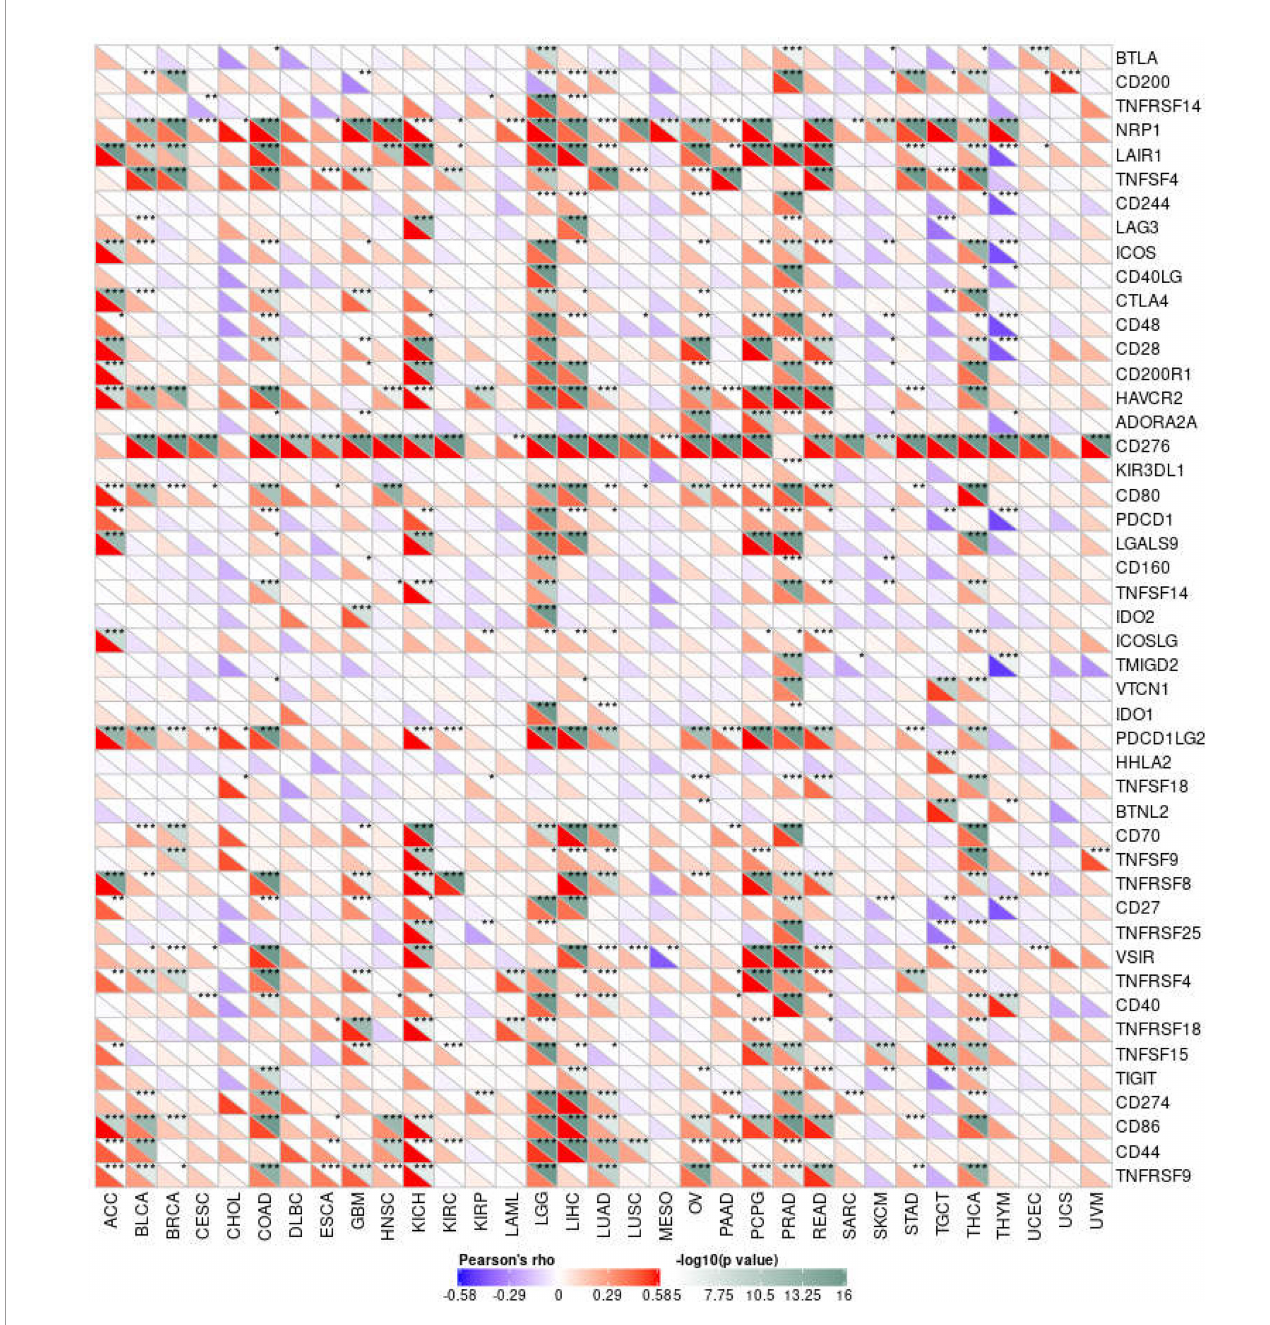
FIGURE 10 | Correlation analysis of MMP14 expression and 47 immune checkpoint genes in endemic cancer.MMP14 was associated with 38 immune checkpoint genes in PRAD, 36 in LGG, 33 in THCA and 24 in KICH. We also found that the immune checkpoint gene CD276 was signi fi cantly associated with MMP14 expression in 28 of 33 tumors (*P < 0.05, **P < 0.01 ***P <